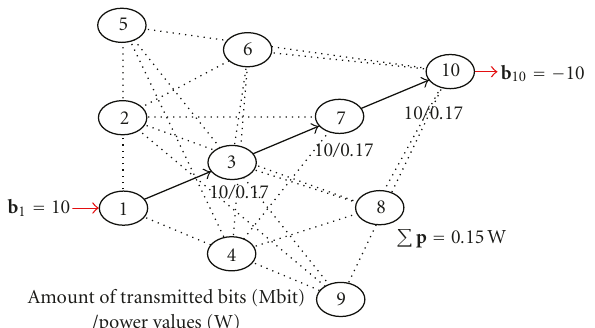
Figure 6: Network [1,3,5,1]: Average rate allocation, Bandwidth B = 5MHz.